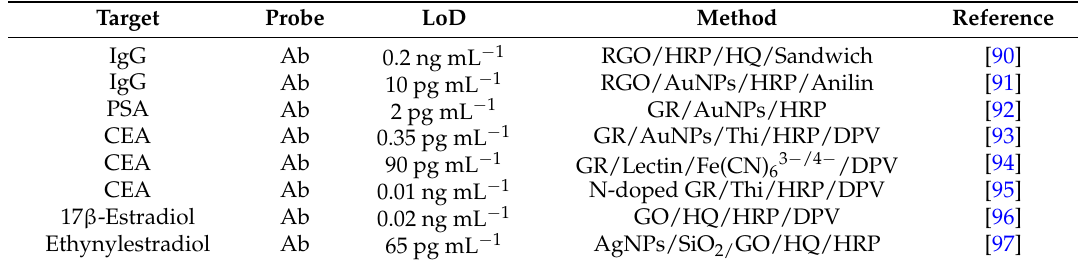
Table 6. Figures of merit of selected enzyme-based immunosensors using